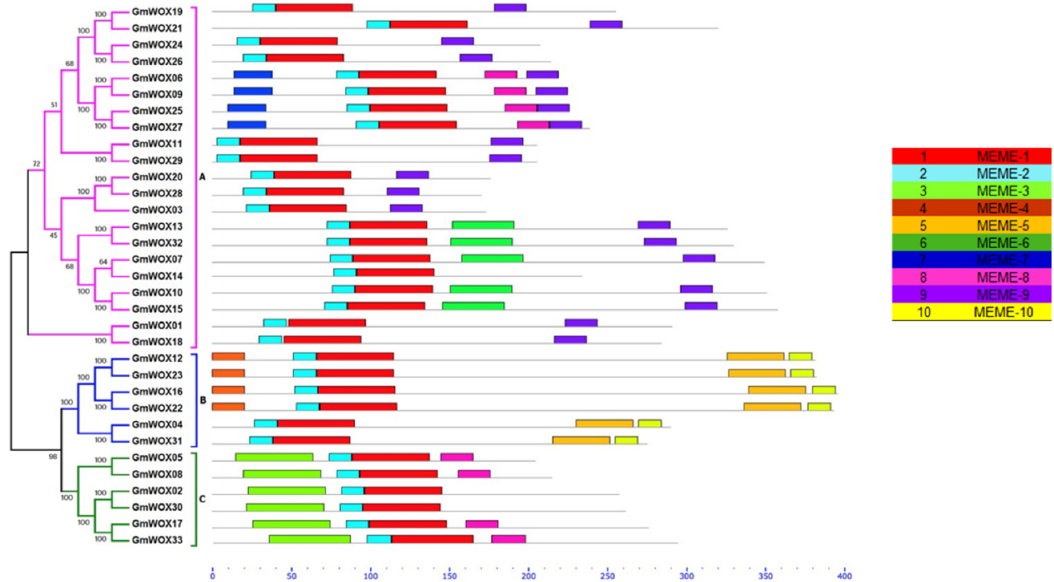
Figure 4. Schematic distribution of the conserved motifs in the soybean WOX family according to MEME. The conserved motifs were identified in the proteins of every group. Each colored box below the tree represents the conserved motifs.